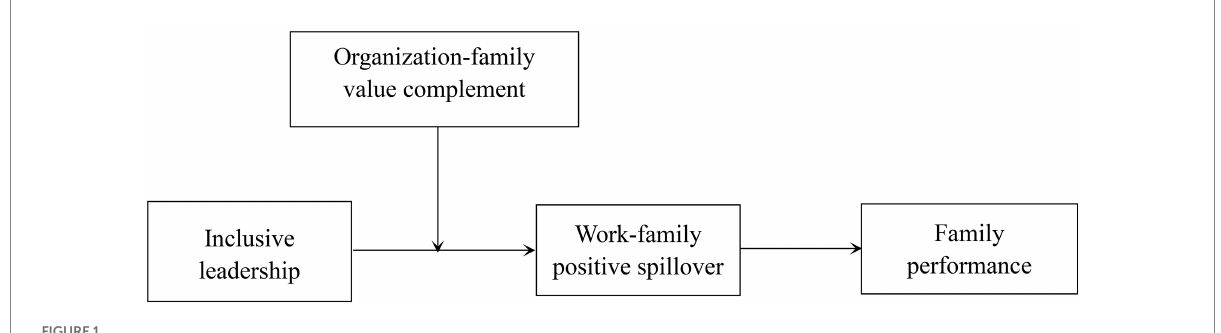
FIGURE 1 Conceptual model of this